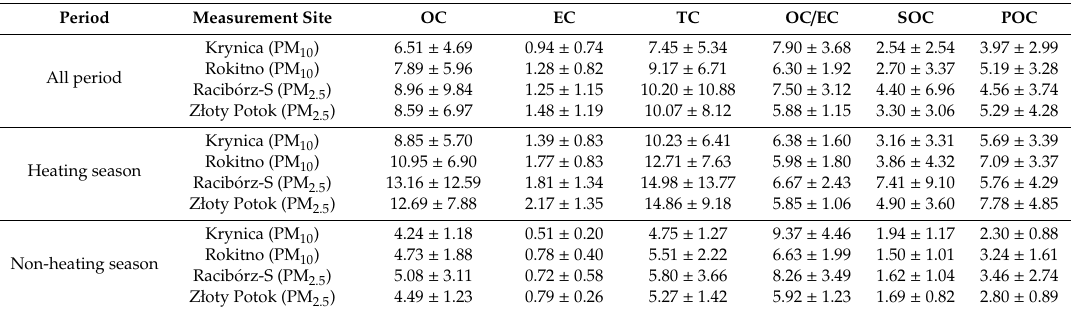
Table 3. Average concentrations of carbonaceous compounds ( µ g · m -3 ), along with the average values of the OC / EC ratio at considered rural background sites.